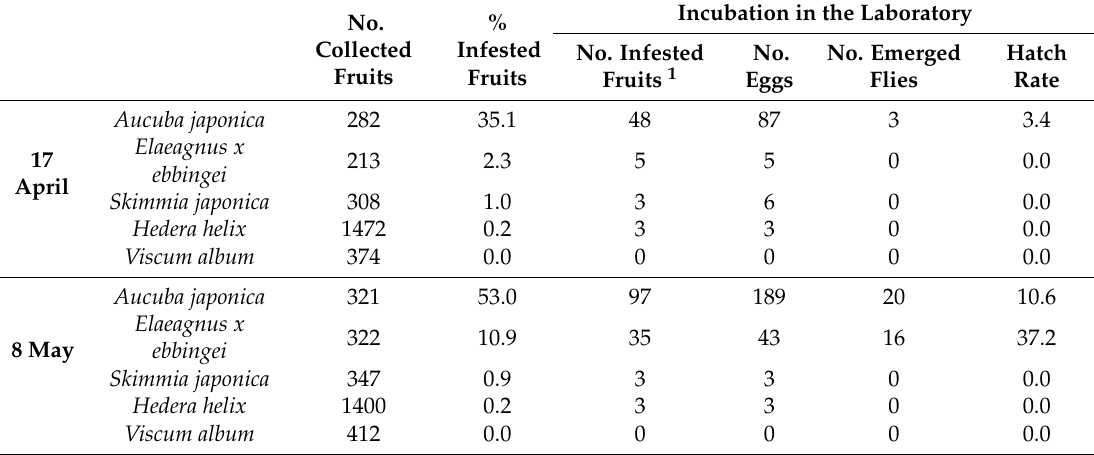
Table 3. Natural infestation of field-collected early spring fruits and successful D. suzukii adult emergence under laboratory conditions. Results are presented as the percentage of collected fruits naturally infested by D. suzukii eggs at two time points in spring 2017. The egg-to-adult survival is assessed by calculating the ratio between the total number of eggs laid on the incubated fruits and the number of flies emerged from these